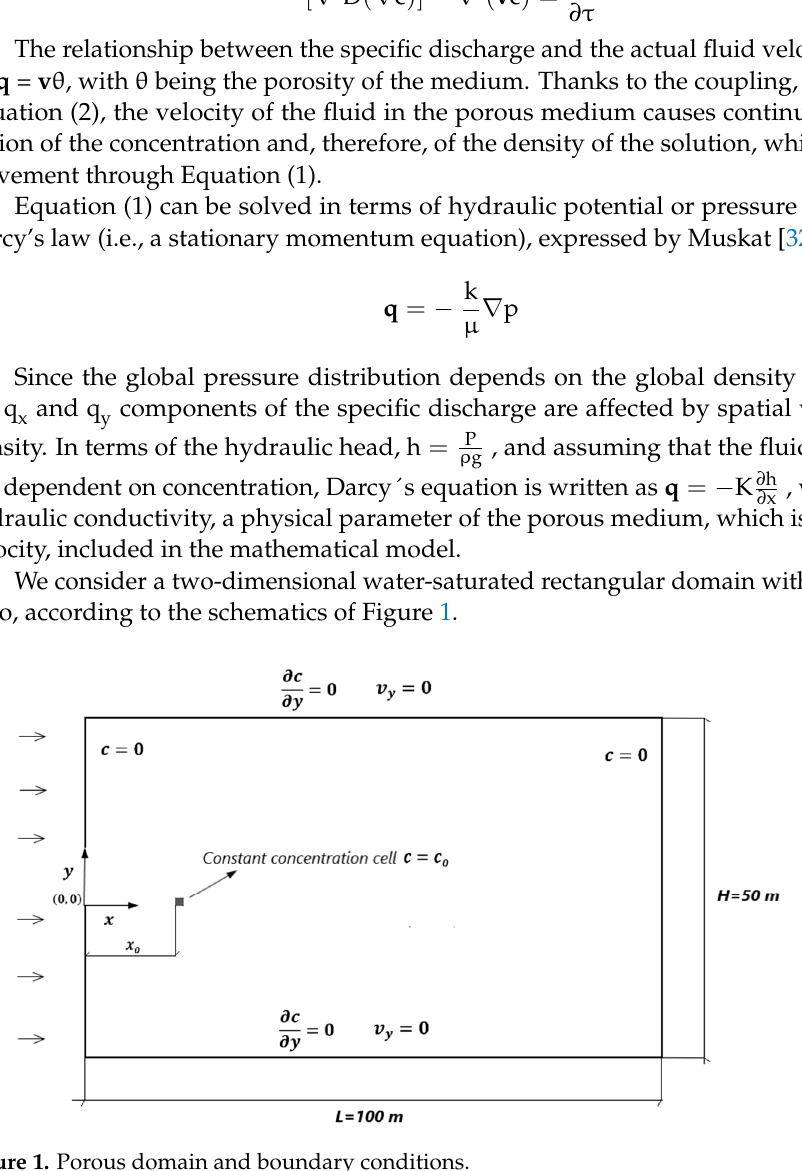
Figure 1. Porous domain and boundary conditions.